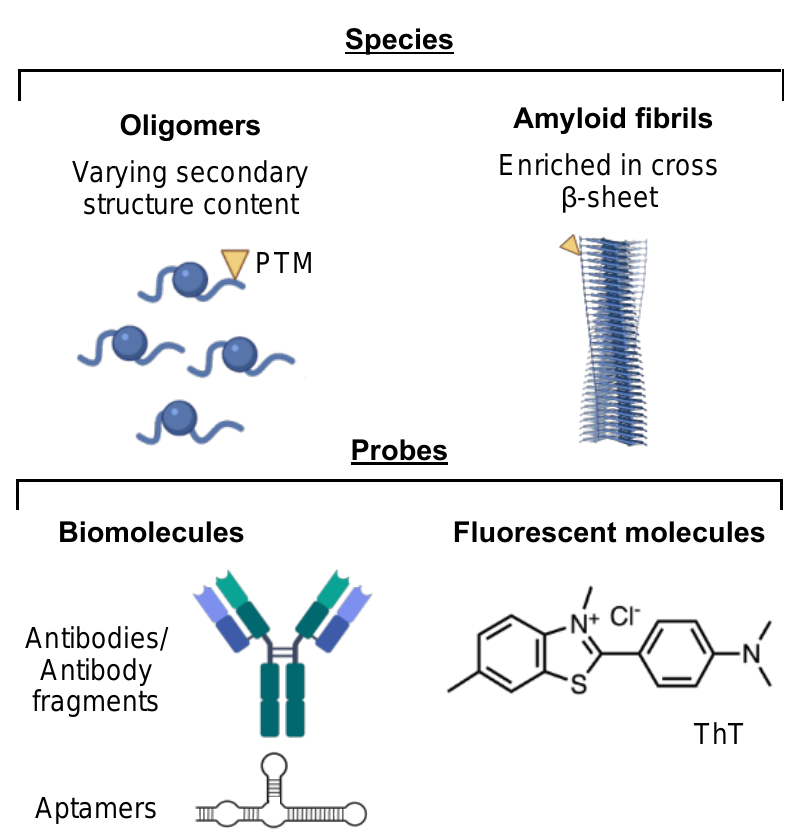
Figure 2. Aggregated protein species and representative probes used for their detection.